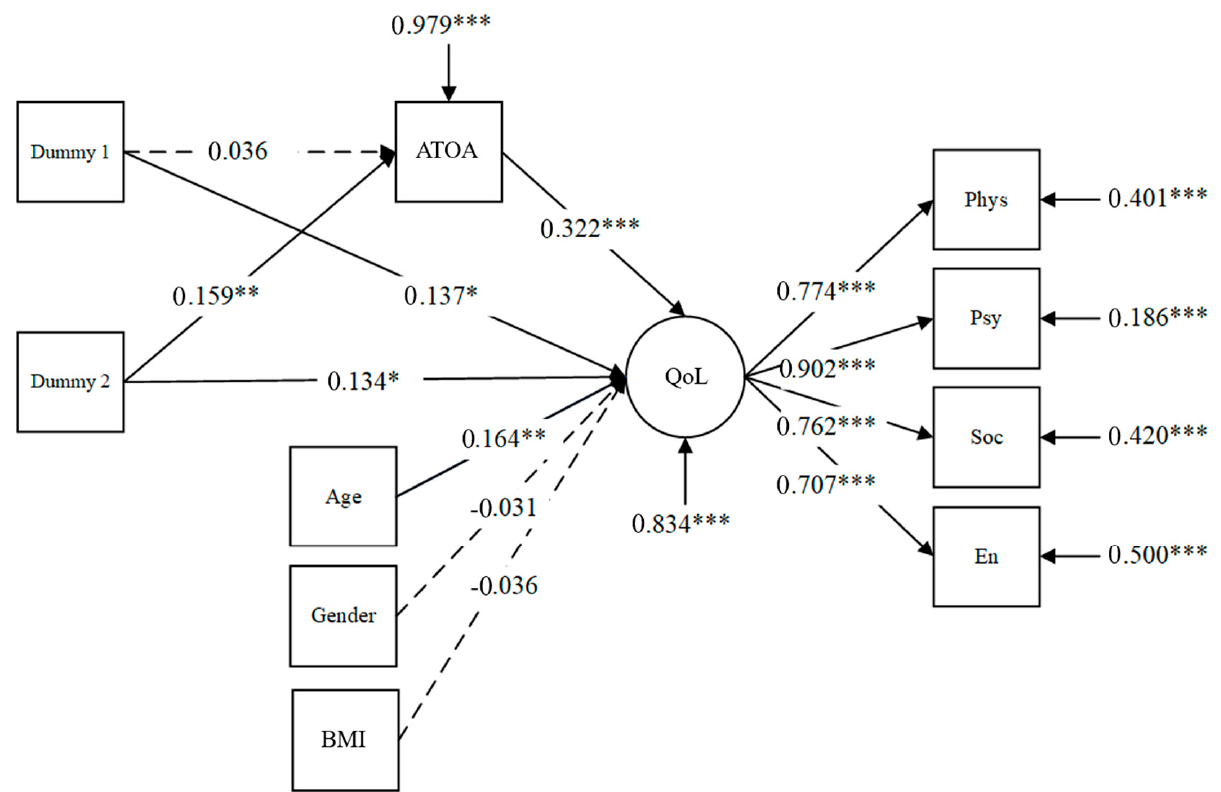
Figure 2. Structural model for QoL. Note: The circles represent latent variables, and rectangles are observed variables. The broken lines indicate effects that are not statistically significant. Path coefficients are standardized MPLUS parameter estimates. The subdomains of QoL scales are: Phys = physical, Psy = psychological, Soc = social, En = environmental. * p < 0.05; ** p < 0.01; *** p < 0.001.